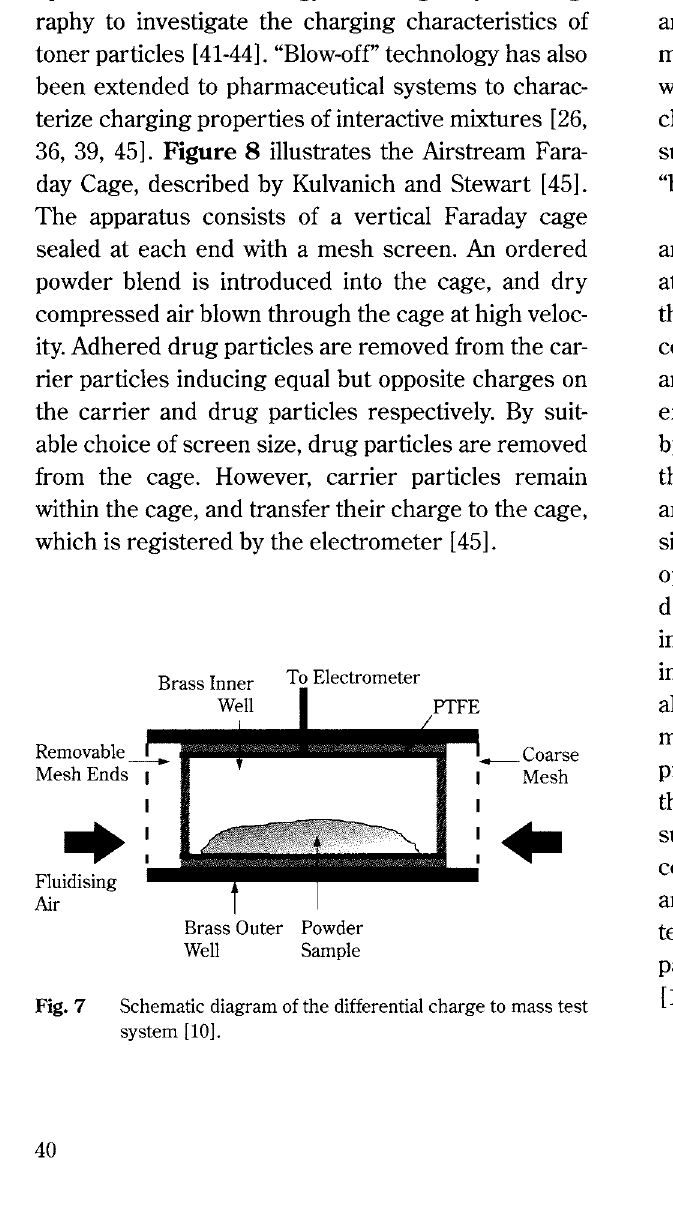
Schematic diagram of the Airstream Faraday cage